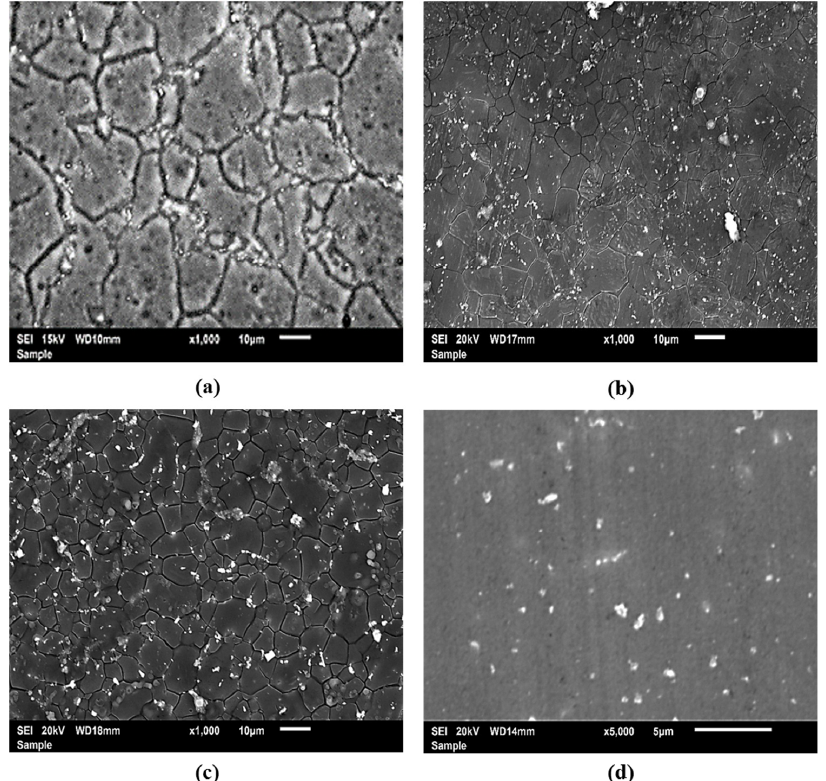
Figure 2. Grain size of ( a ) pure Mg, ( b ) Mg1.5NiTi, ( c ) Mg3NiTi; ( d ) NiTi distribution in the Mg matrix.